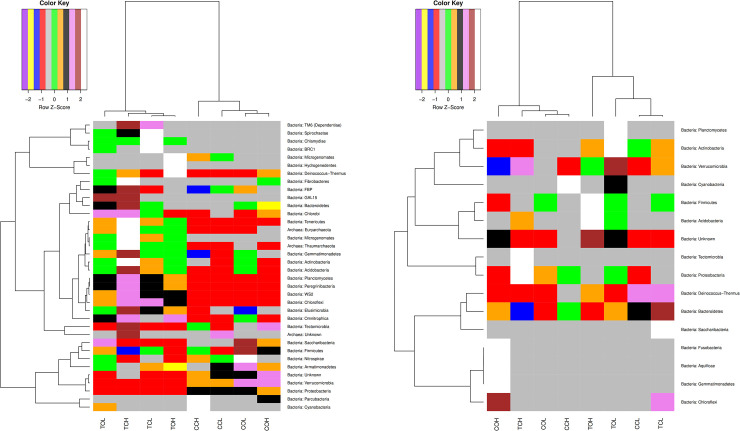
a and b. Hierarchical clustering of the most predominant prokaryotic taxa at phylum level within each farming system of 16S rDNA and 16S rRNA cDNA datasets in both sites. X-axis indicates the replicates within each system while the Y-axis indicates the taxonomic relationships. Total and active prokaryotic diversity is represented by a and b, respectively. CCL = Chuka Conv-Low; COL = Chuka Org-Low; CCH = Chuka Conv-High; COH = Chuka Org-High and TCL = Thika Conv-Low; TOL = Thika Org-Low; TCH = Thika Conv-High; TOH = Thika Org-High.